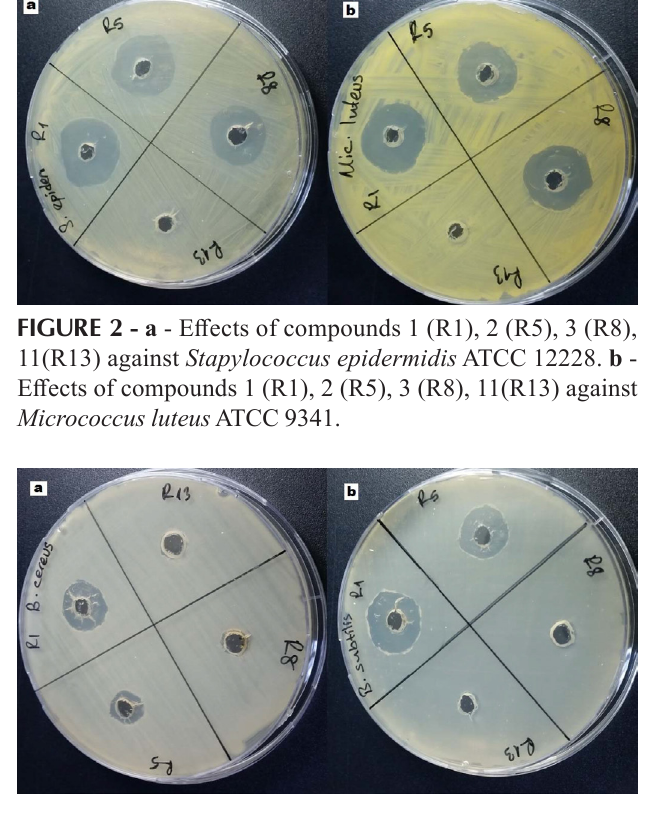
FIGURE 3- a - Effects of compounds 1 (R1), 2 (R5), 3 (R8), 11(R13) against Bacillus cereus ATCC 11778. b - Effects of compounds 1 (R1), 2 (R5), 3 (R8), 11(R13) against Bacillus subtilis ATCC